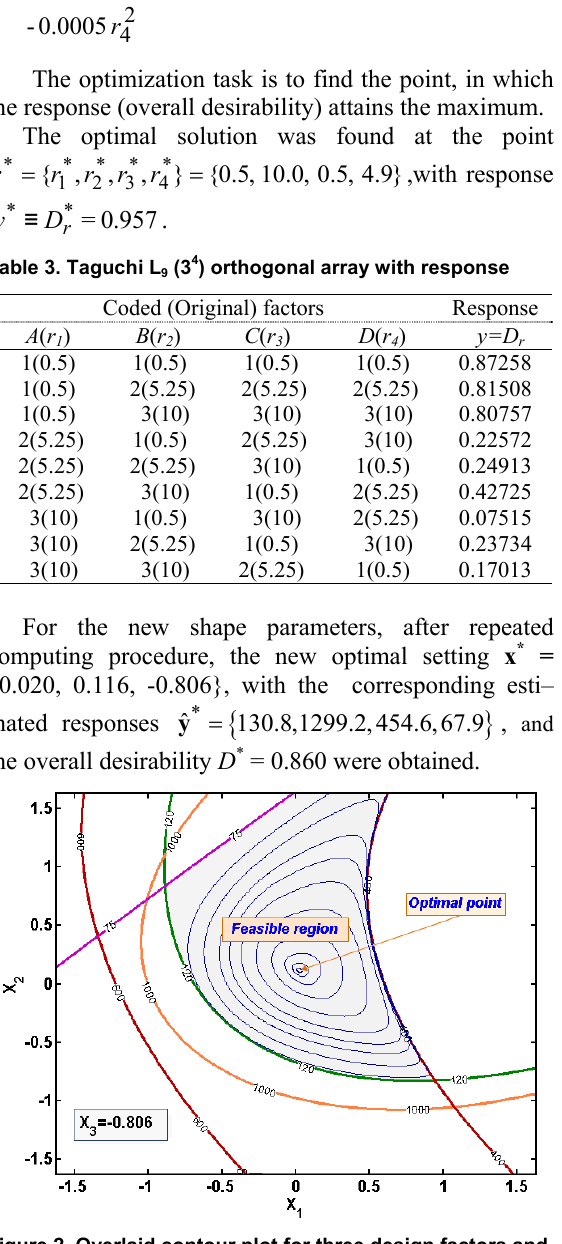
Figure 2. Overlaid contour plot for three design factors and four response constraints with x3: sulfur at optimal level